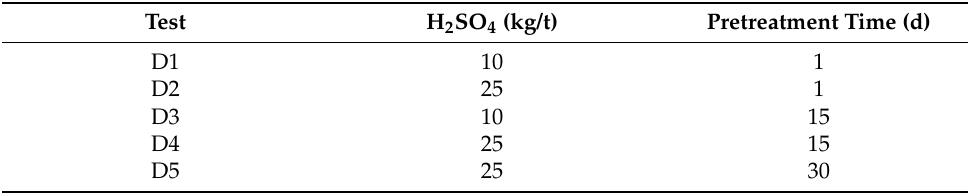
Table 6. Experimental conditions of pretreatment (50 kg/t NaCl, 6% humidity) tests D.